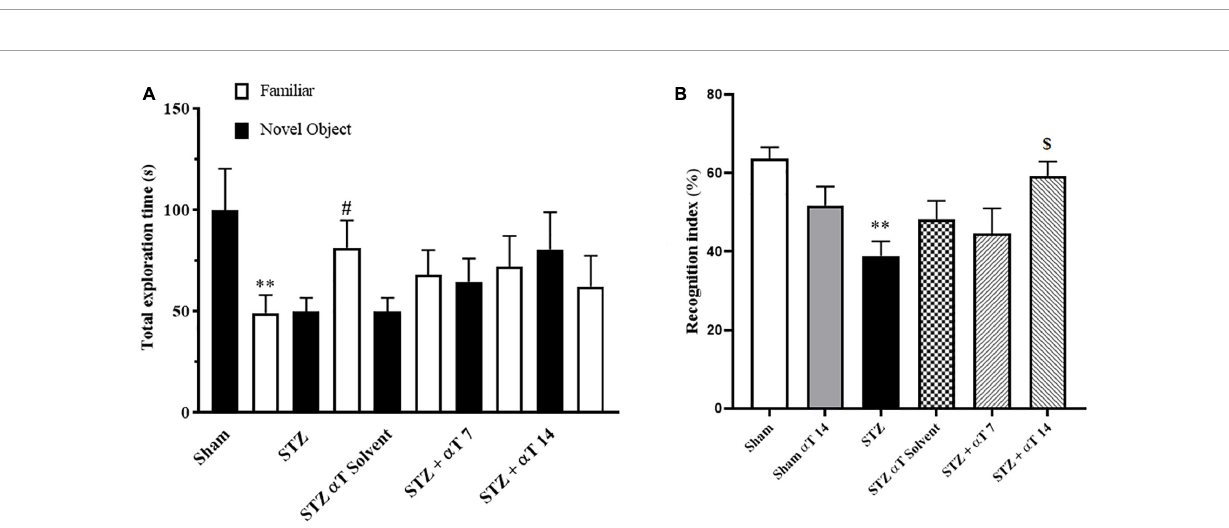
FIGURE3 Performance on the NOR task for total exploration time and recognition index. (A) One-way ANOVA indicated a significant difference between the icv-STZ groups and the sham group for the whole exploration time ( ∗∗ P < 0.01 in the sham and # P < 0.05 in the icv-STZ group; there is no significant difference in the treatment groups). (B) One-way ANOVA indicated a significant difference between the icv-STZ groups and the sham group on the recognition index ( P < 0.05). Tukey’s post-hoc analyses indicated sham, and α -Tocopherol (STZ + α -Tocopherol 14) groups animals spent less time on familiar objects compared to novel objects ( ∗∗ P < 0.05 between sham versus icv-STZ and $ P < 0.05 STZ versus STZ + α -Tocopherol 14 groups) ( n = 9). All graphs were plotted as mean ±